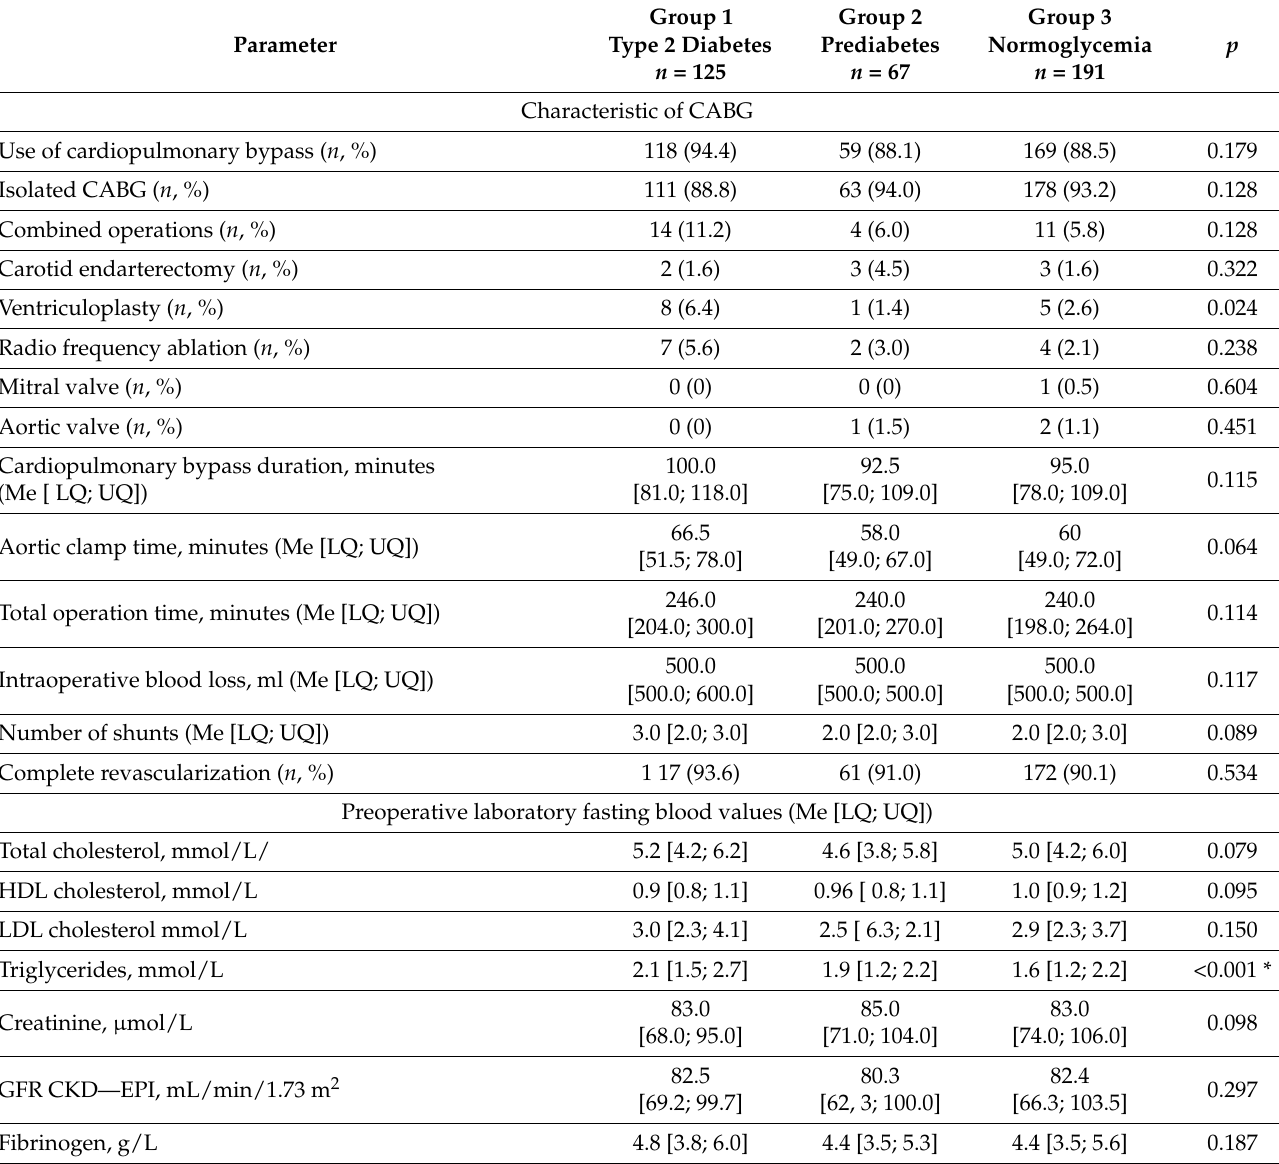
Table 2. Characteristics of the operation and routine laboratory